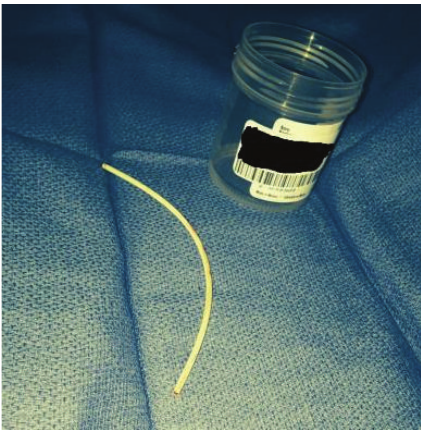
Figure 8: Embolized catheter fragment.